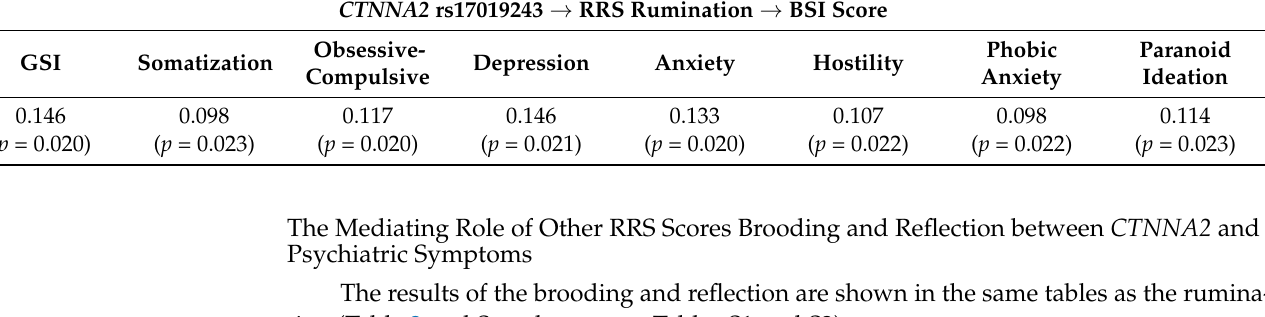
Figure 3. Structural equation modeling to test the direct and indirect effects of CTNNA2 rs17019243 for BSI psychiatric symptom scores via RRS rumination within the same model. Model fit indices: χ 2 = 20.184 (df = 14; p = 0.1244); RMSEA = 0.026 (PCLOSE = 0.949); CFI = 0.999; TLI = 0.992. Direct effects of rs17019243 are displayed in the figure, and the significant ( p ≤ 0.05) one is marked in bold. The results suggest that rs17019243 has a direct effect on RRS rumination, but has no direct effect on any of the BSI scores. BSI—Brief Symptom Inventory; RRS—Ruminative Response Scale; df—degrees of freedom; RMSEA—root mean squared error of approximation; PCLOSE—significance of the statistical hypothesis that RMSEA is different from the desirable ≤ 0.05; CFI—comparative fit index (>0.90 indicates a good model fit, and >0.95 indicates a very good model fit); TLI—Tucker − Lewis index (>0.90 indicates a good, and >0.95 a very good model fit). Table 3. Standardized estimates of the indirect effects of CTNNA2 rs17019243 on each BSI score via RRS rumination. All mediated effects are significant at a p ≤ 0.05. We can see that rs17019243 acts on eight BSI scores via RRS rumination, with the strongest effect on GSI, depression, anxiety, obsessive-compulsive, and paranoid ideation scores. RRS—Ruminative Response Scale; BSI—Brief Symptom Inventory; GSI—global severity index.